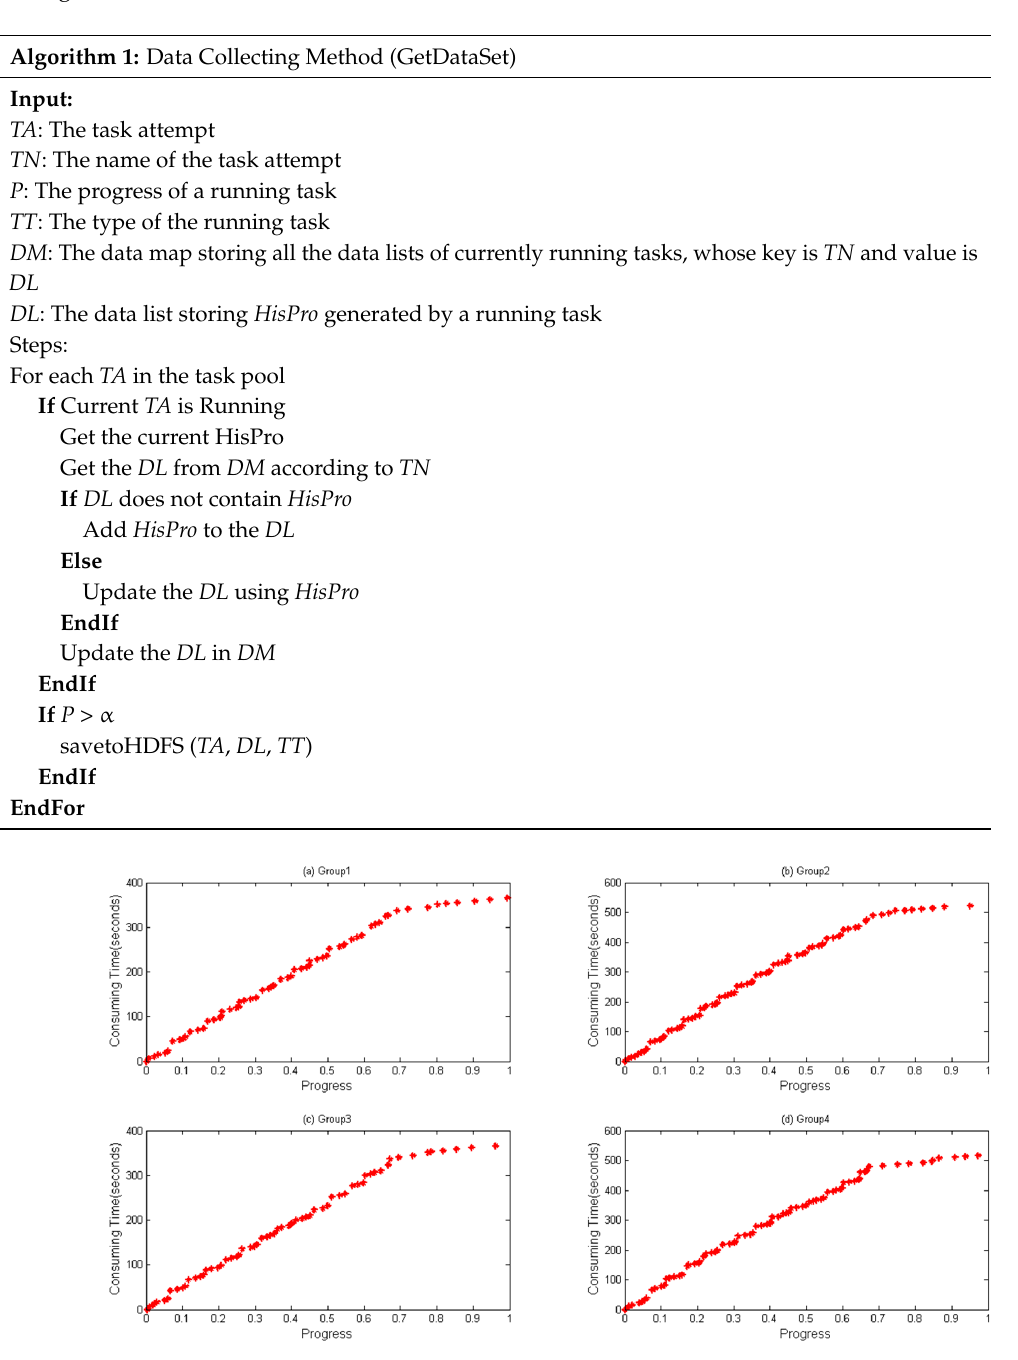
Algorithm 1: Data Collecting Method (GetDataSet)